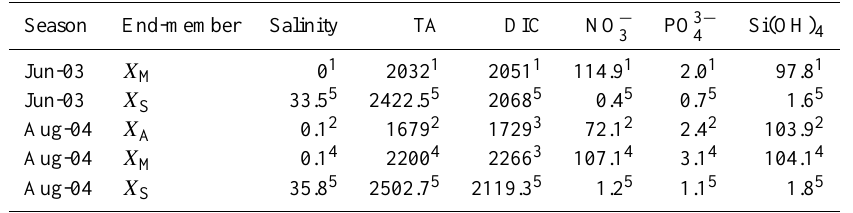
Table 1. End-members of the Mississippi River ( X M ), the Atchafalaya River ( X A ), and marine end ( X S ) for DIC, TA and nutrient values in June 2003 and August 2004. Unit:µmoll − 1 , except salinity. Uncertainties: 0.1% for TA and DIC, and the detection limits for nutrients